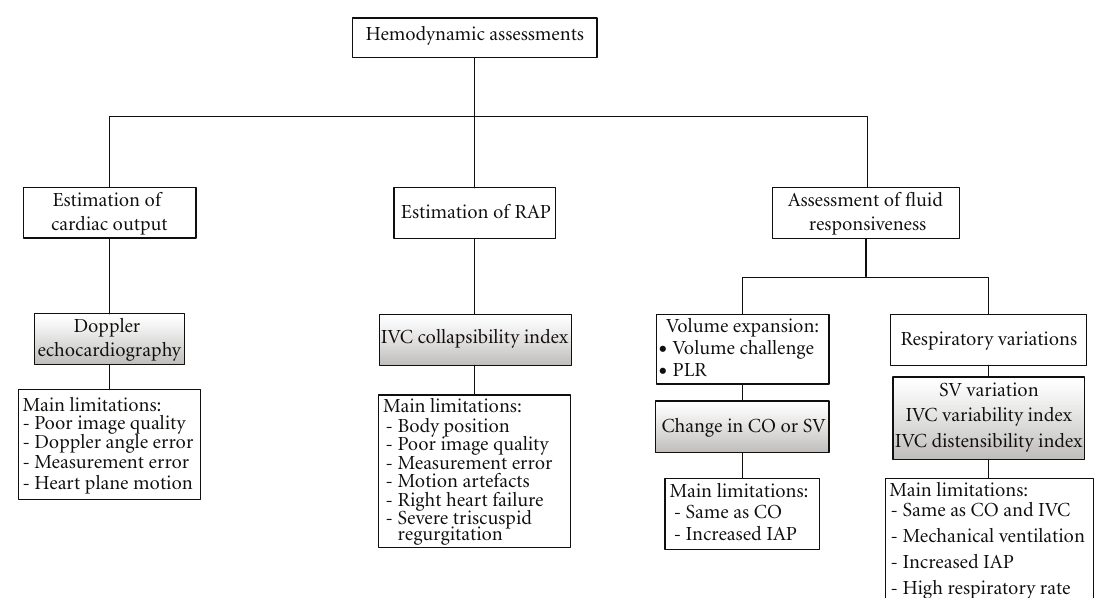
Figure 6: Summary of hemodynamic assessment by transthoracic